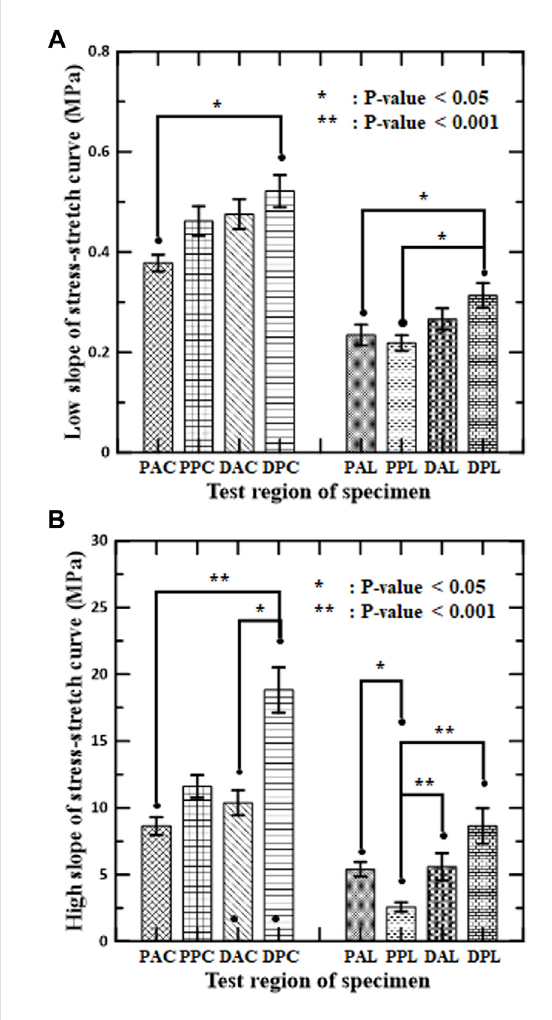
FIGURE 4 Mean and standard error of mean for slopes ofstress – stretch curves of aortic tissues in (A) low-stiffness regimes and (B) high- stiffness regimes for circumferential and longitudinal specimens, respectively.